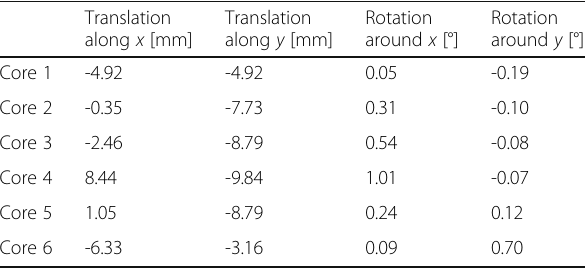
Table 2 Misalignment algorithmically determined for CT acquisitions of sediment